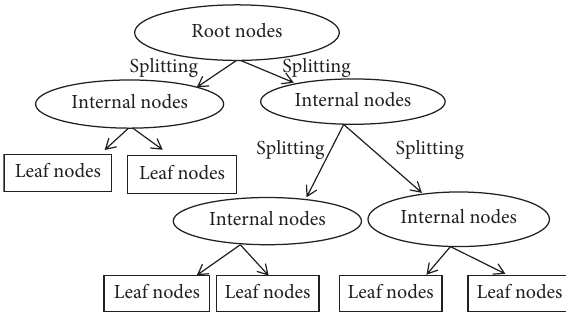
Figure 1: Structural flow of decision tree